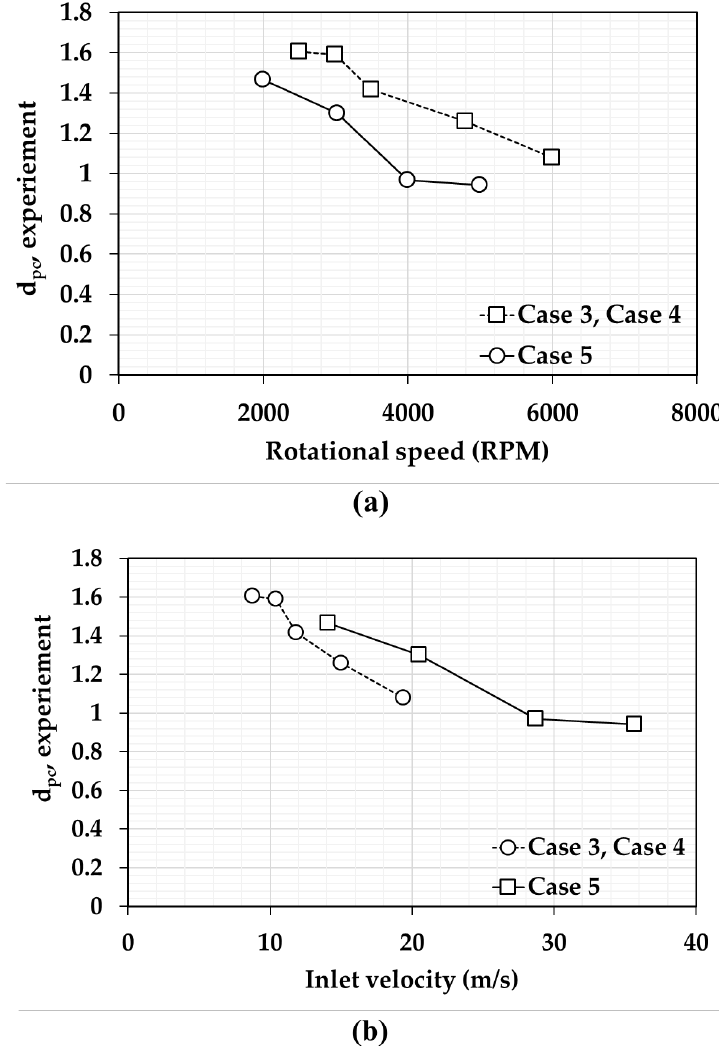
Figure 8. Experimental d pc values derived by reference to: ( a ) the rpm of the cyclone separator and ( b ) inlet velocity of the cyclone separator.